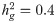
Multiple logistic regression improves power of GWAS with additional controls.We simulated phenotypes with varying case/control ratio—(a) 1625/1625, (b) 1625/3250, (c) 1625/4875 and (d) 1625/6500 respectively—using 100 loci of ∼200 SNPs, as described in the main text. All simulations used hg2=0.4. We compared the ranking of SNPs at each locus using recall (solid lines, left y-axis) and precision (dotted lines, right y-axis), which were averaged over 100 loci and 20 simulation replicates. All methods were run with a maximum of two causal SNPs per locus. Insets schematically compare logistic model with linear model (see Fig 1 for details). B-LORE shows increasingly more recall over other methods with addition of more controls, i.e., decreasing case/control ratio, because the logistic function becomes increasingly better than the linear function to model the data.